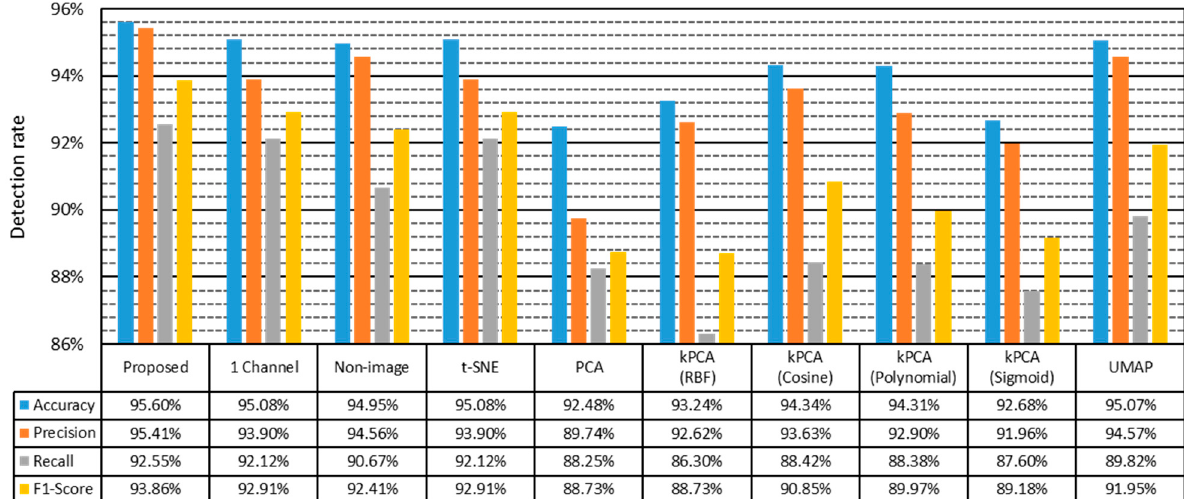
Figure 5. Detection rate for each algorithm on the ISCXIDS2012 dataset.